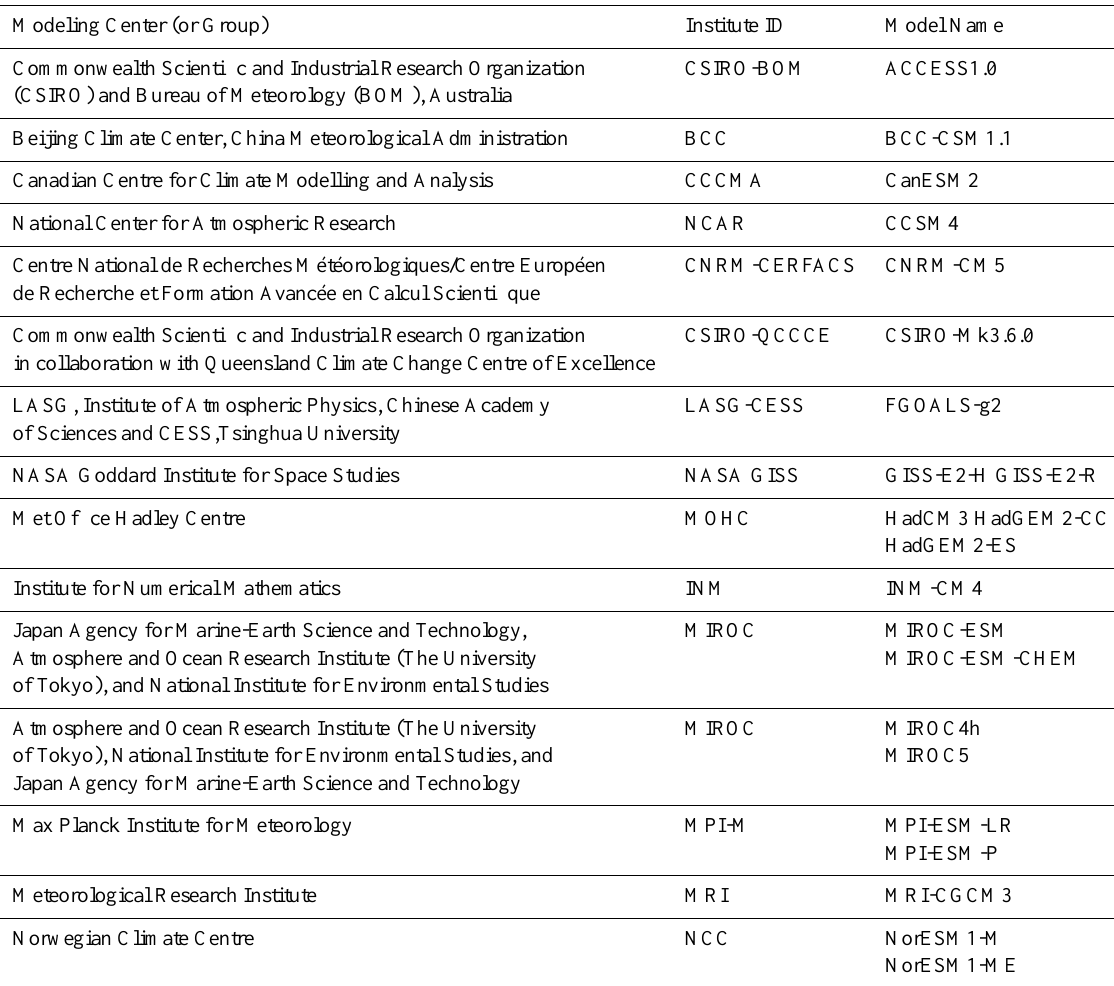
Table 1. CMIP5 models, groups and acronyms (see http://cmip-pcmdi.llnl.gov/cmip5/). Modeling Center (or